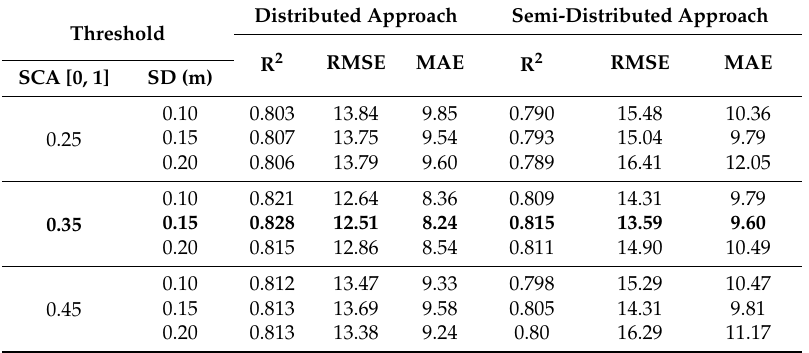
Table 2. Unmixing_wholesnow (UWS) threshold selection for various snow thicknesses selected as thresholds for the 2008–2009 and 2009–2010 snow seasons for distributed and semi-distributed simulations. Bold values indicate the selected snow depth and snow cover area (SCA)